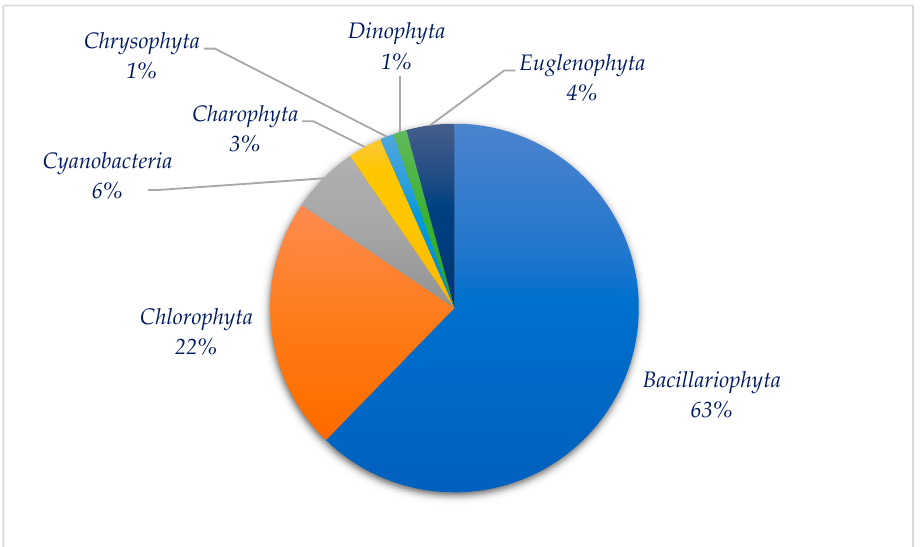
Bacillariophyta 63%